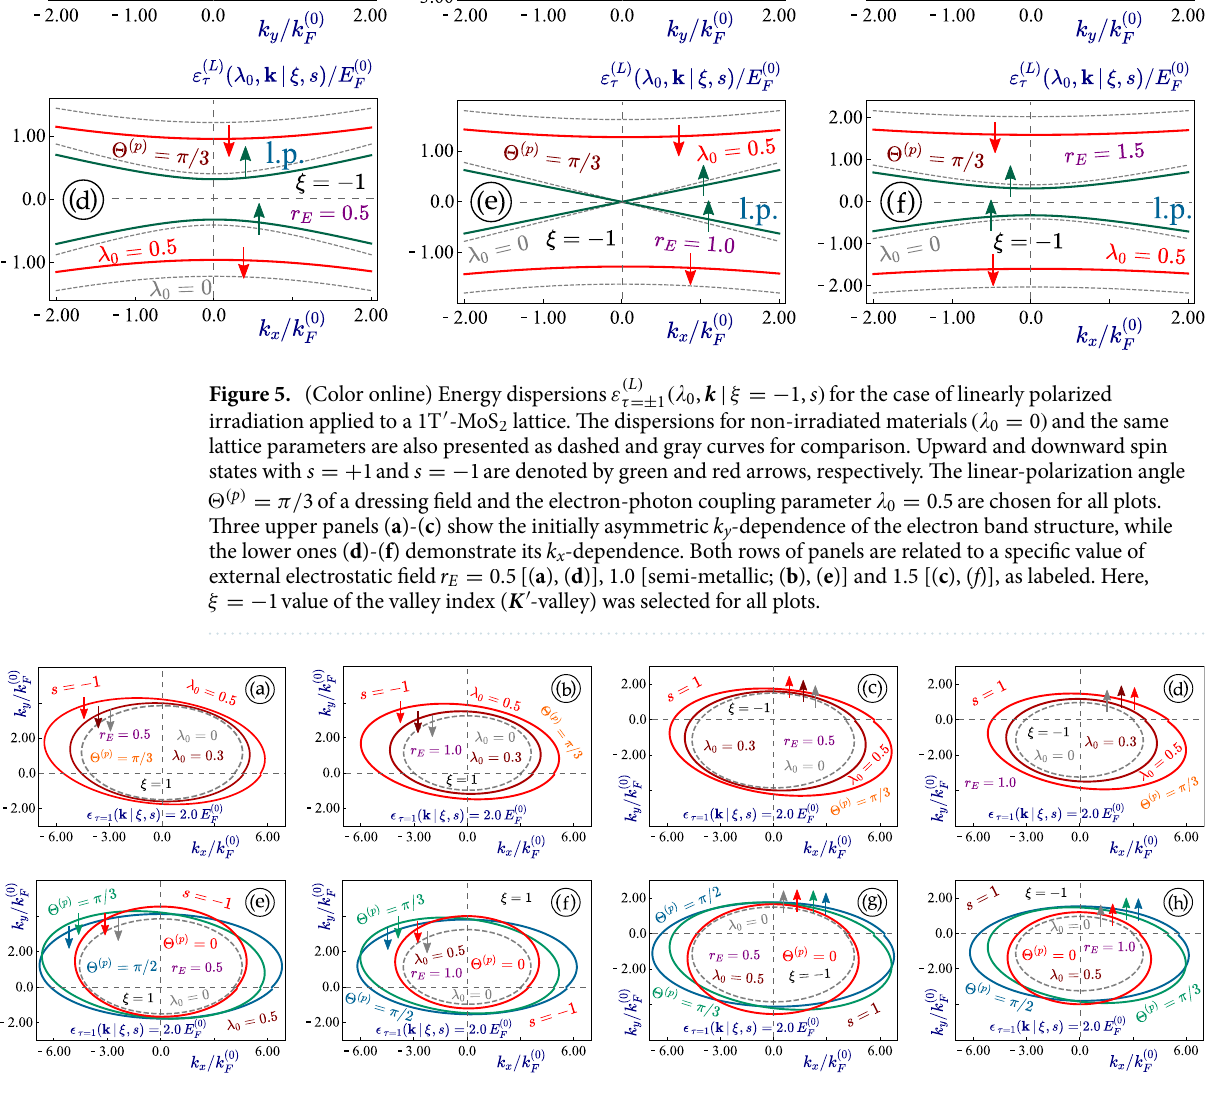
( L ) k ) 2.0 E ( 0 ) Figure 6. (Color online) Angular dependence of the equienergy ε 0 ( F cut of the dispersion = ξ , s ) for 1T ′ -MoS 2 in the presence of a linearly-polarized dressing field. The highest subband with ε ( L ) 0 ( k | 1 (and ξ 1 was selected for all plots. Here, a negative spin index s 1 ) was chosen for panels ξ s = − = − = + 1 and ξ 1 are assumed for plots ( c ), ( d ), ( g ), ( h ). Two different values of the ( a ), ( b ), ( e ), ( f ), while s = = − 0.5 and r 1.0 (semimetallic) were used as labeled. For the upper panels perpendicular electric field r E E = = ( a )-( d ), each curve corresponds to a different value of the coupling parameter (cid:31) 0 , while for the lower ones, it is related to different values of the polarization angle � ( p ) as seen. In each plot, a non-irradiated material with (cid:31) 0 is also shown by a gray dashed 0 =